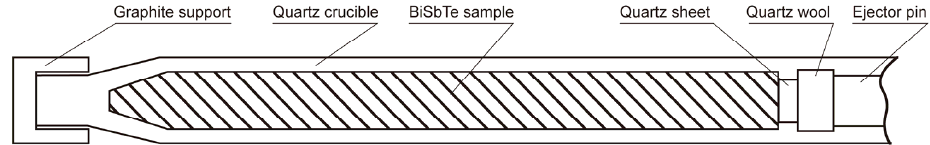
Figure 1. Customized ampoule